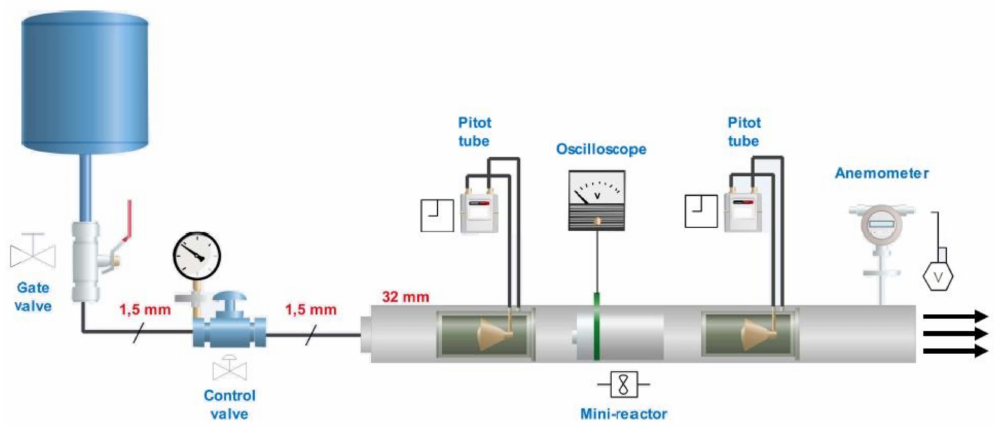
Figure 13. Test set-up diagram to measure wind power for the mini wind harvester model.